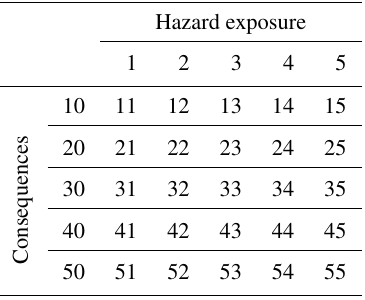
Table 2. Matrix used to combine hazard exposure with PDI and